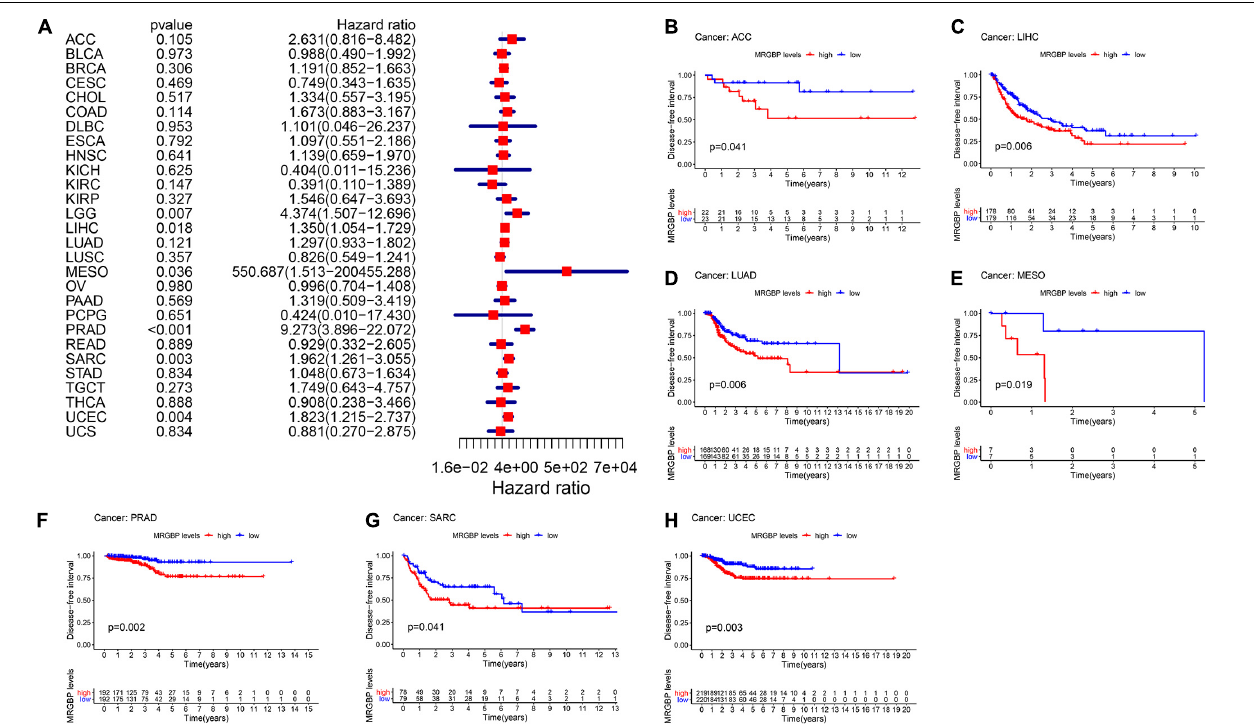
FIGURE 4 | Relationship between MRGBP expression and disease-free interval (DFI) in 33 tumors. The forest plots were calculated using univariate Cox regression (A) and the survival curves were calculated using Kaplan-Meier survival methods (B–H) .